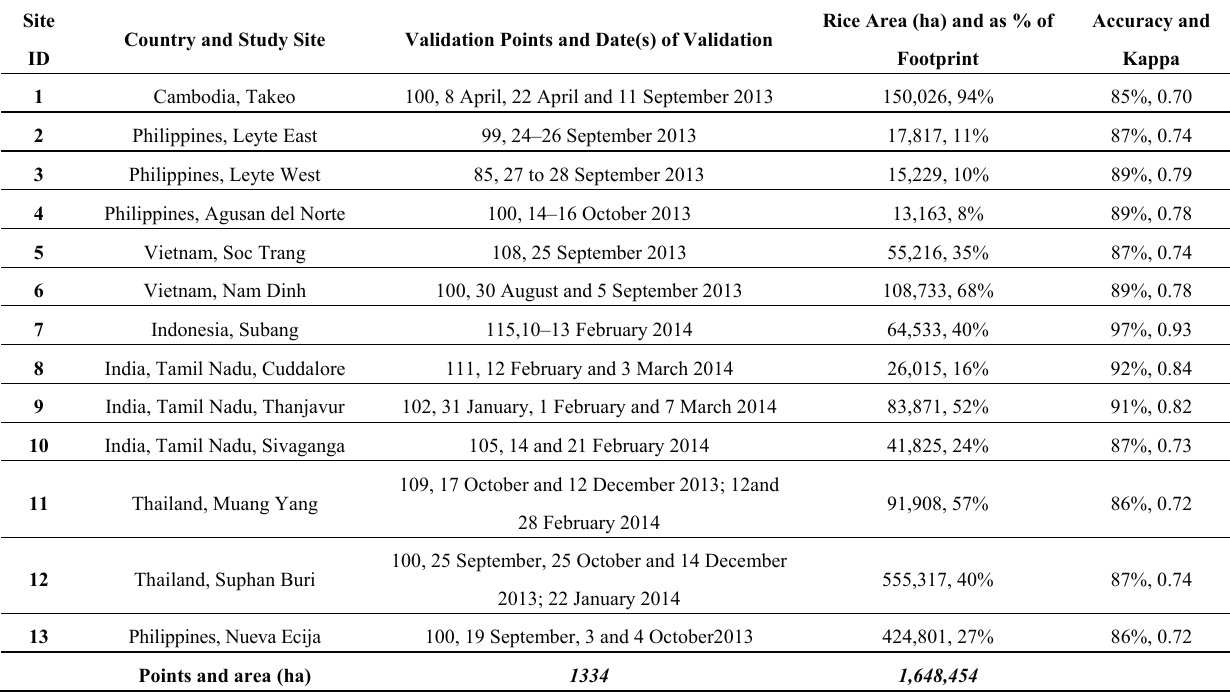
Table 5. Summary of site validation visits, rice area and accuracy